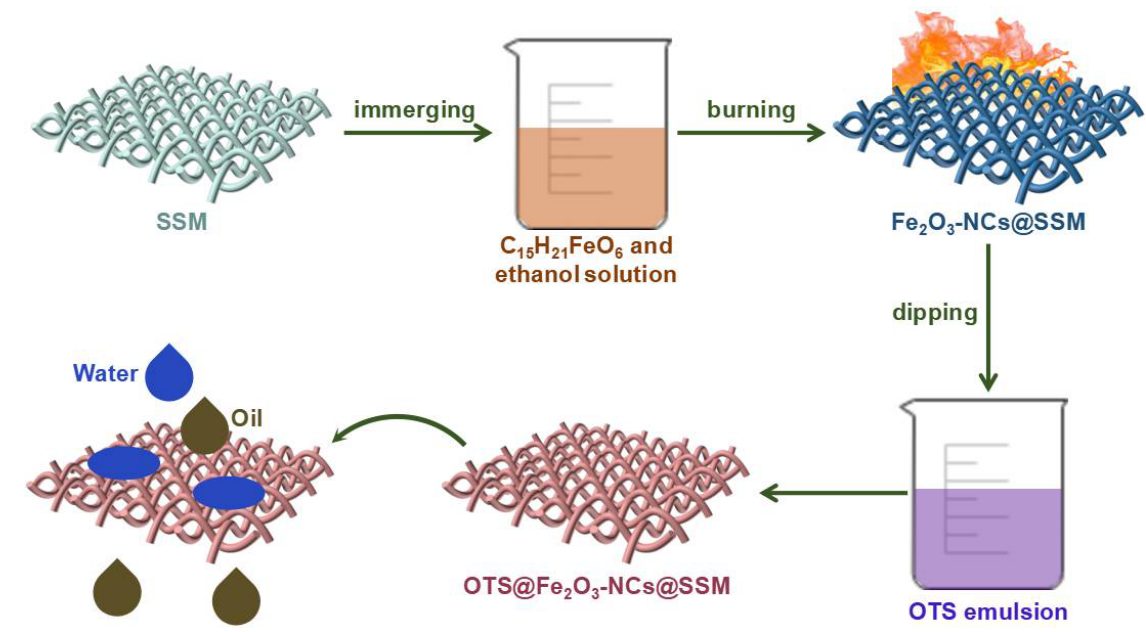
Figure 1. Schematic illustration of the preparation of OTS@Fe 2 O 3 -NCs@SSM.